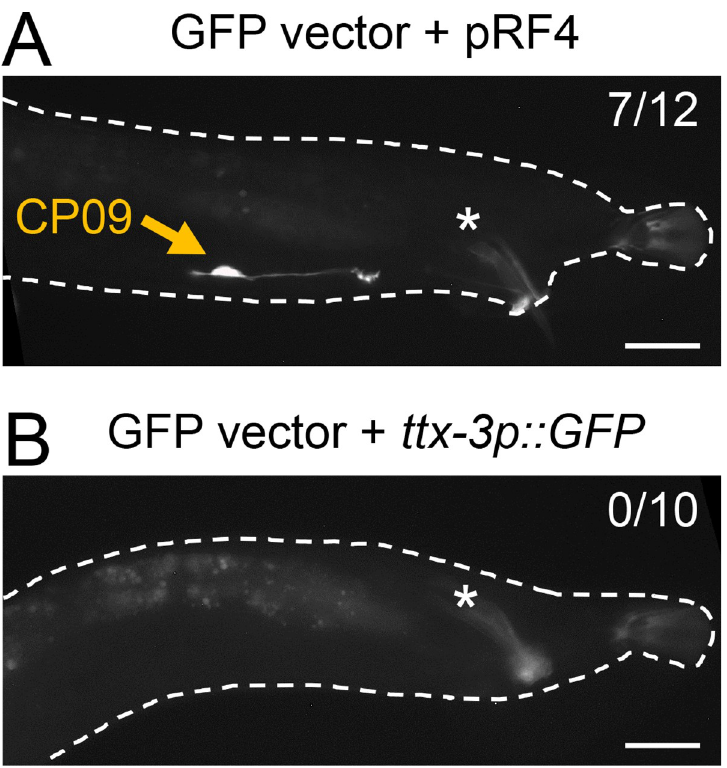
Fig 2. The rol-6 co-injection marker causes an expressional artifact in CP09. GFP expression in the male tail of transgenic worms injected with an empty GFP vector (pPD95.75) along with rol-6(su1006) plasmid (pRF4) (A) or ttx- 3p :: GFP plasmid (B). Exclusive CP09 expression was observed in seven out of 12 independent transgenic lines injected with GFP vector + pRF4 (7/12), whereas no CP09 expression was observed in 10 independent lines with GFP vector + ttx-3p :: GFP (0/10). Asterisks indicate autofluorescence in the spicule. Scale bar, 20 μ m.